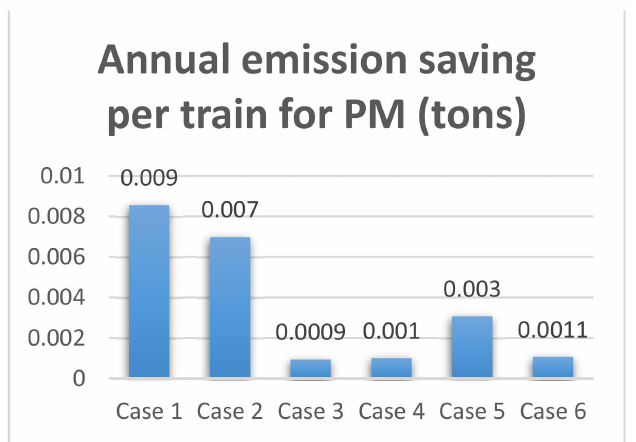
Figure 9. Comparison of annual emission saving per train for PM (tons) for the six cases when using the electric brake regenerative